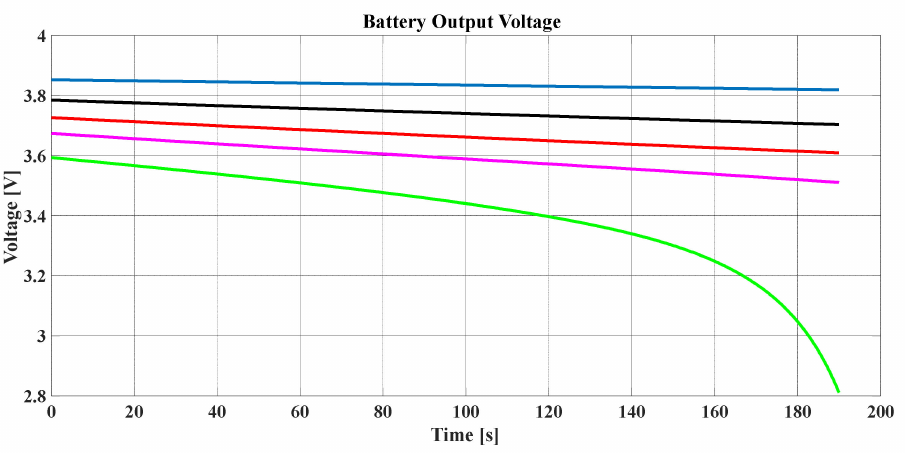
Figure 16. The battery voltage based on the TPM.